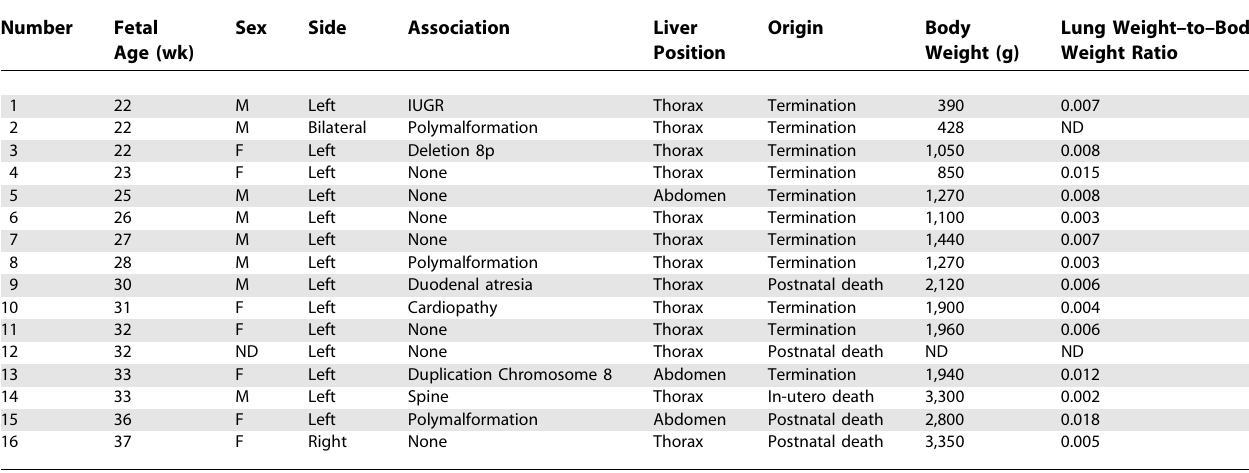
F Right None Thorax Postnatal death 3,350